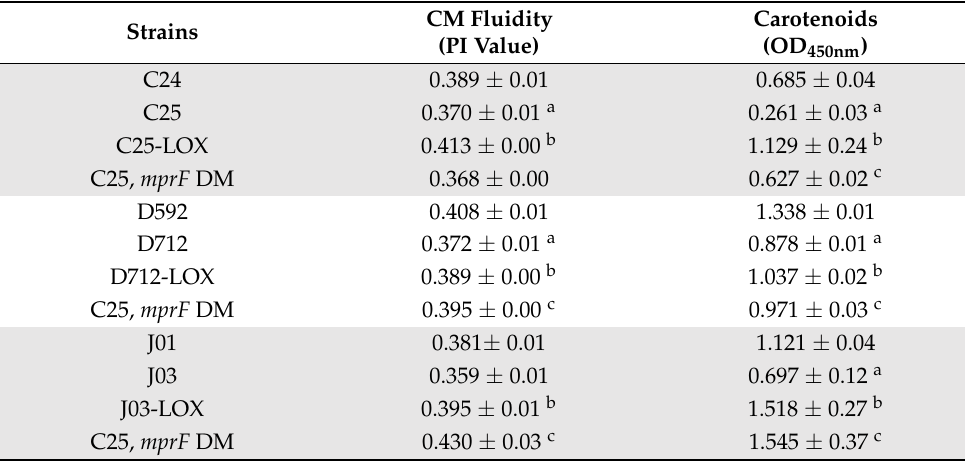
Table 5. CM fluidity and carotenoid content of study